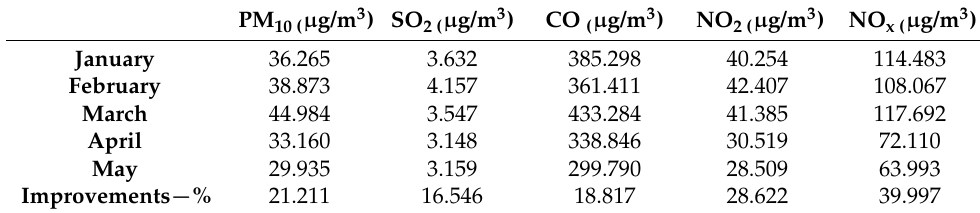
Figure 4. The maps of changes of air quality. The red color indicates the positive situation and the blue color the negative situation. However, the improvement ratios of air quality parameters are presented Table 2. Table 2. Month-based air quality